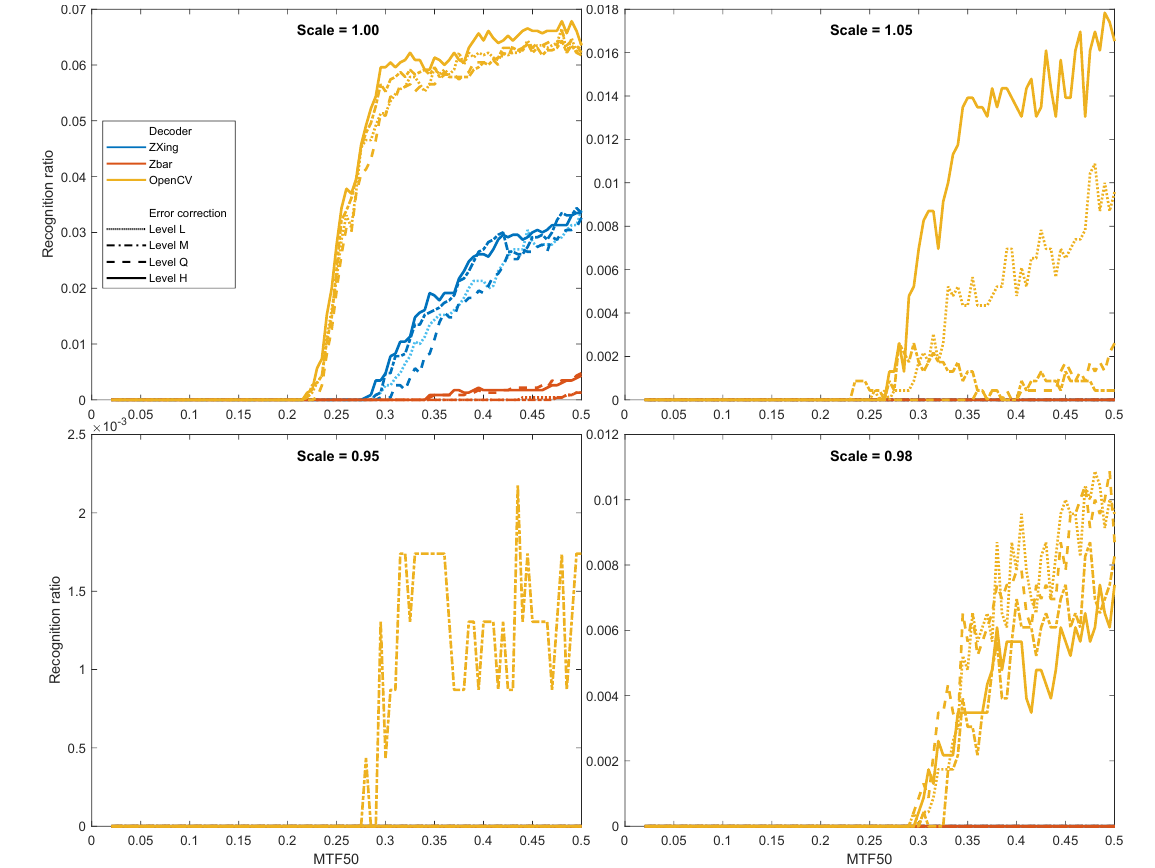
Figure 13. Recognition ratio of QR code decoding near the Nyquist (Scale = 1) limit. (The blue and red lines that ‘disappeared’ in three subplots are actually there, but at zero